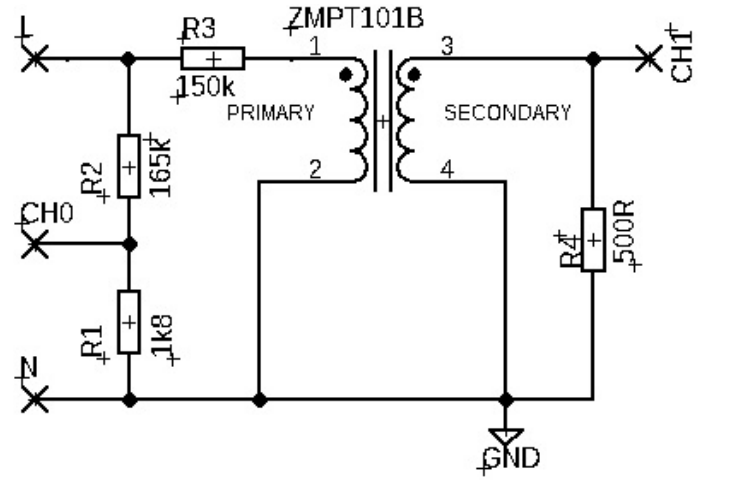
Figure 5. The wiring diagram of the fixture with the stand-alone current transformer ZMPT101B. The fifth fixture tested was a simple circuit with two optocouplers consisting of LED– photodiode pair. HCPL-4562 integrated circuits with LED and photodiode connected to the transistor base were selected. However, the current output of the photodiode was used directly for the measurement. In order to process both positive and negative half wave of the input AC 230 V signal, the LEDs were connected antiparallel with common current limiting resistors. The antiparallel connection of the LEDs also ensured the limitation of the shutter voltage on the LEDs. The size of the input limiting resistors was chosen by the mean current of the LEDs corresponding to their nominal average forward current value of 12 mA. Each of the photodiodes was connected to its own reverse voltage source, and the bipolar output signal was read at the measuring resistor 20 k Ω . An operational amplifier connected as a voltage follower was inserted between the measuring resistor and the fixture output. The fixture with the optocouplers connected is shown in Figure 1e. Although the circuit was implemented on a solderless breadboard, the nature of the output signal was not affected, but the use of a printed circuit board and soldering of components may result in less signal noise. The wiring of the fixture can be seen in Figure